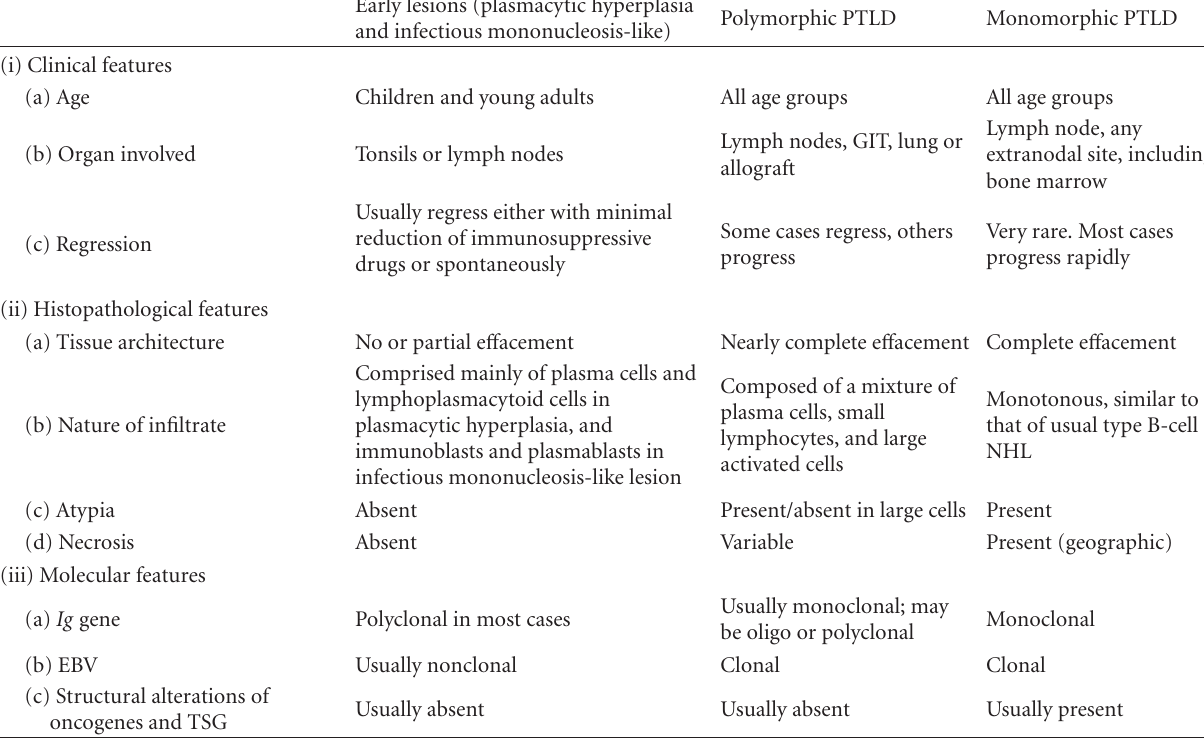
Figure 1: A typical case of polymorphic PTLD. (a) Infiltrate is a mix of plasma cells, small lymphoid cells and larger cells with nucleoli. The cells are positive for CD20 (b), CD30 (c), MUM1 (d), EBER (e), and EBV-LMP-1. Magnification: (b,d): × 100; (a,e,f): × 200. Table 2: Clinicopathologic features of major types of posttransplant lymphoproliferative